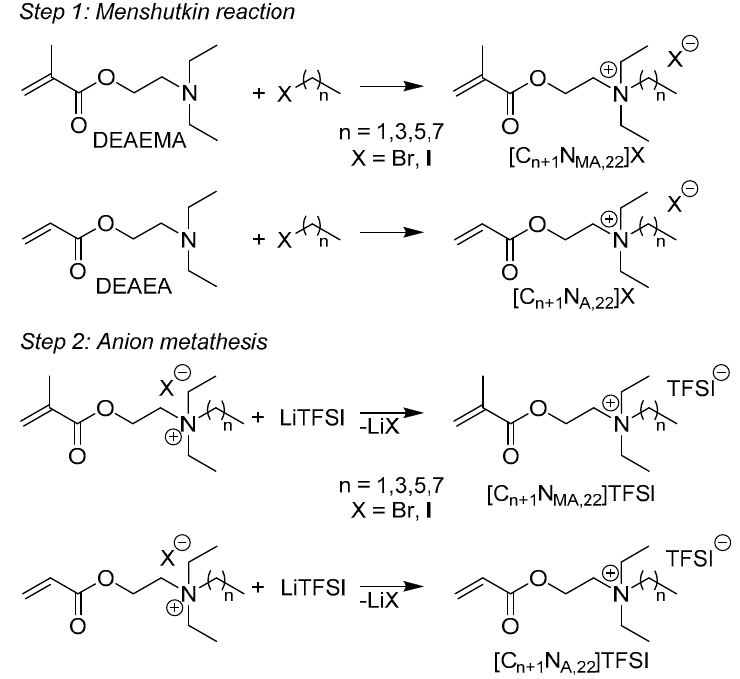
Figure 1. Reaction scheme for the preparation of the IL and notation.